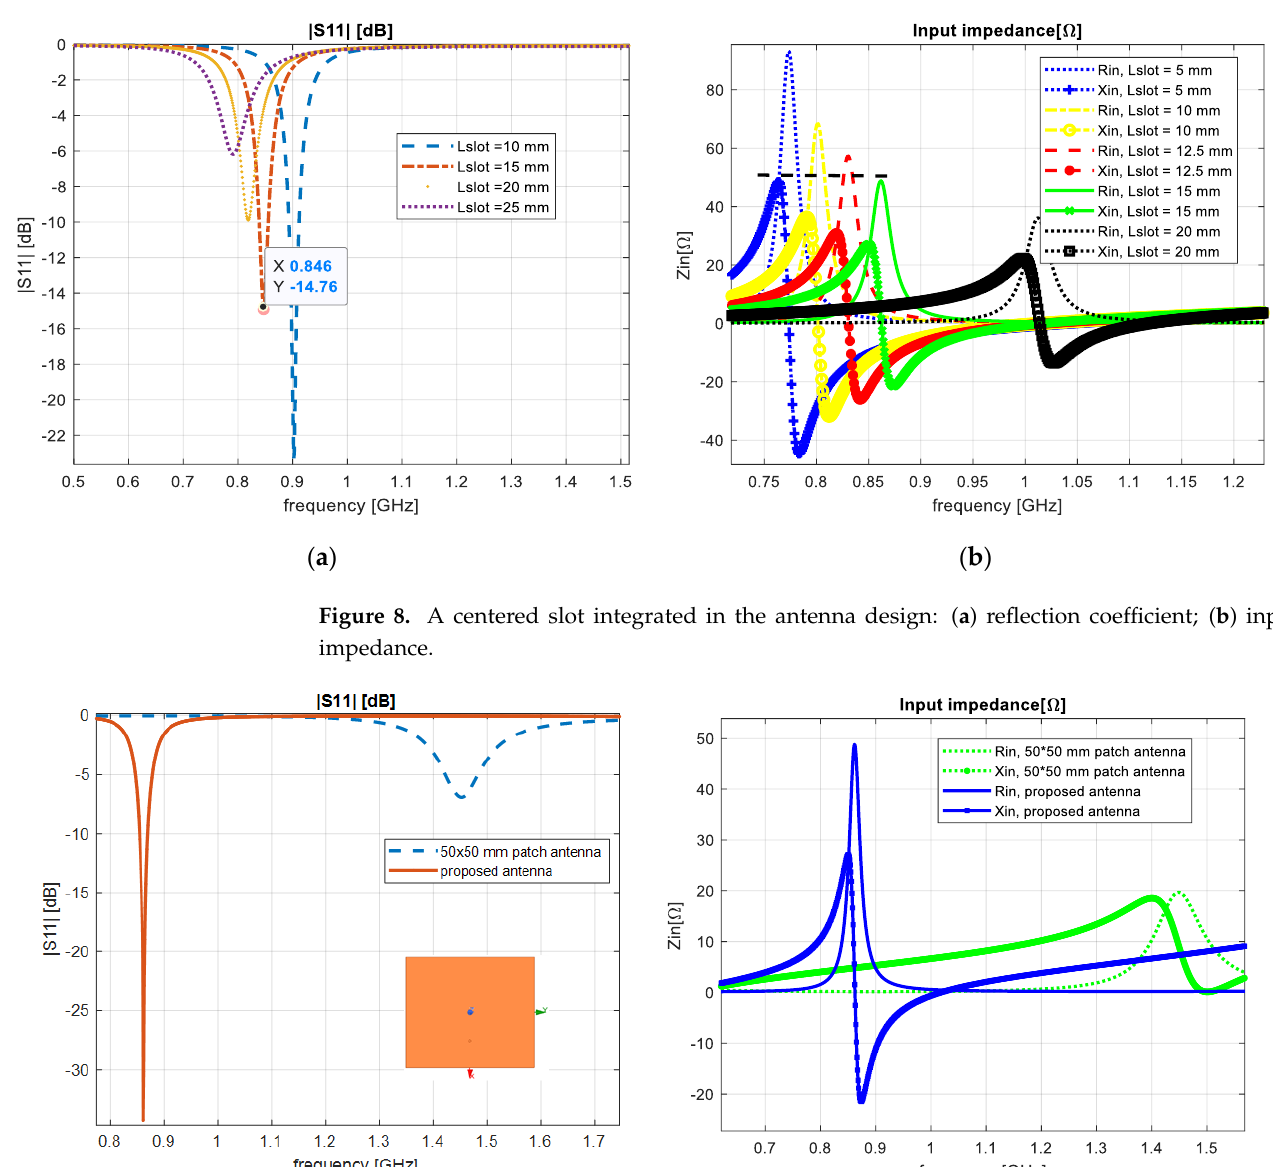
8 of 14 Figure 7. Varying the notches ’ position: ( a ) reflection coefficient; ( b ) input impedance. The next design step was to insert an interior slot of rectangular form that would be